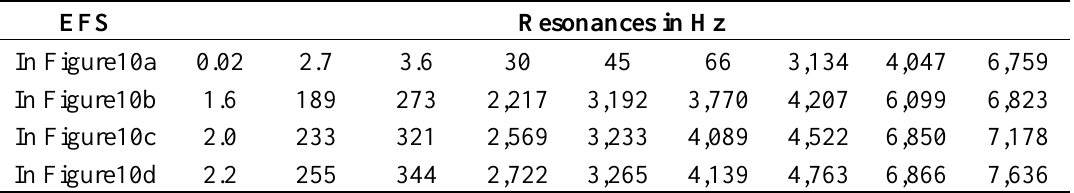
Table 4. Modal analysis of the plate solid bridge.